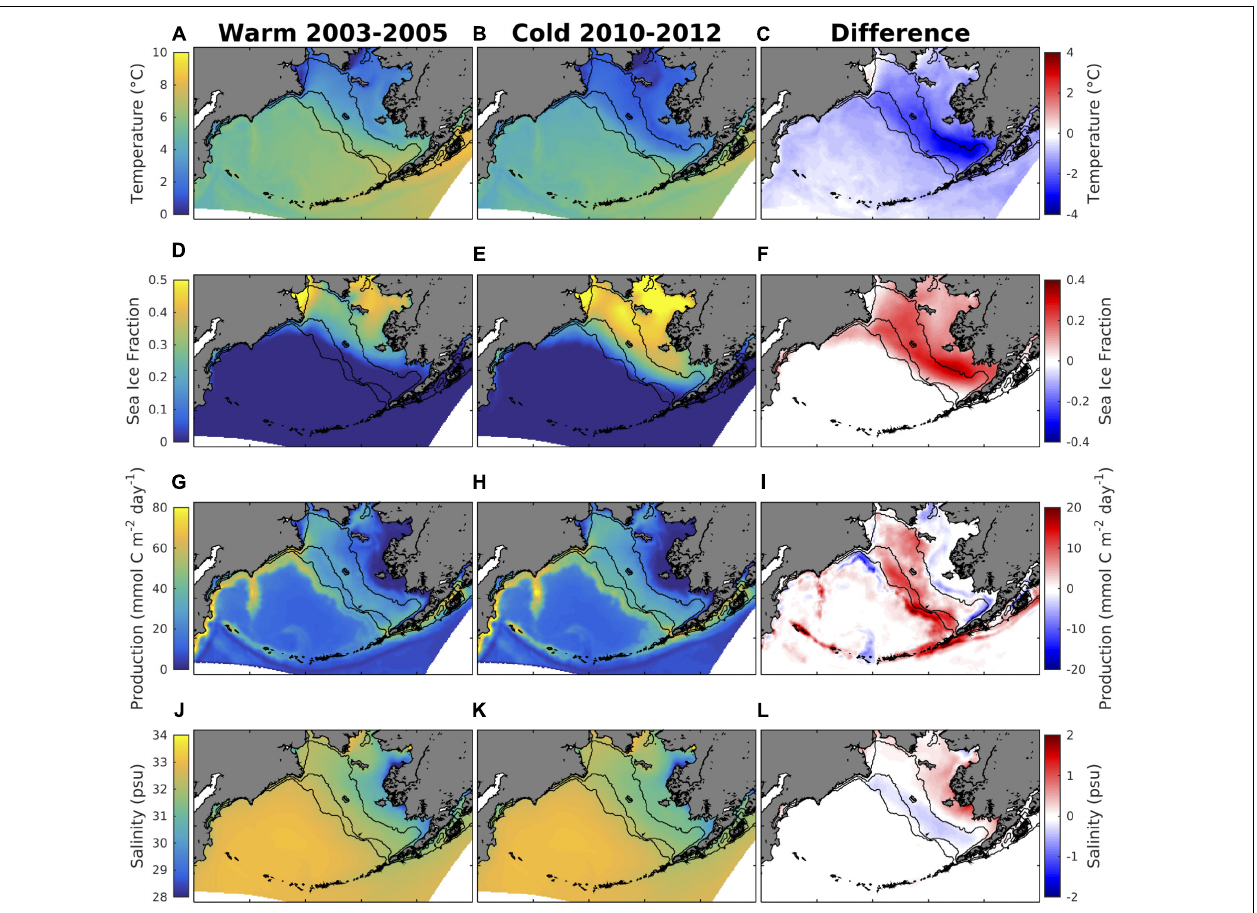
FIGURE 9 | (left) Model annual mean variables averaged over the warm and (middle) cold temperature regimes, and (right) the difference generated by the transition from warm to cold conditions. (A–C) Surface temperature, (D–F) fraction of grid cell covered by sea ice, (G–I) production integrated over the top 200 m of the water column, and (J–L) surface